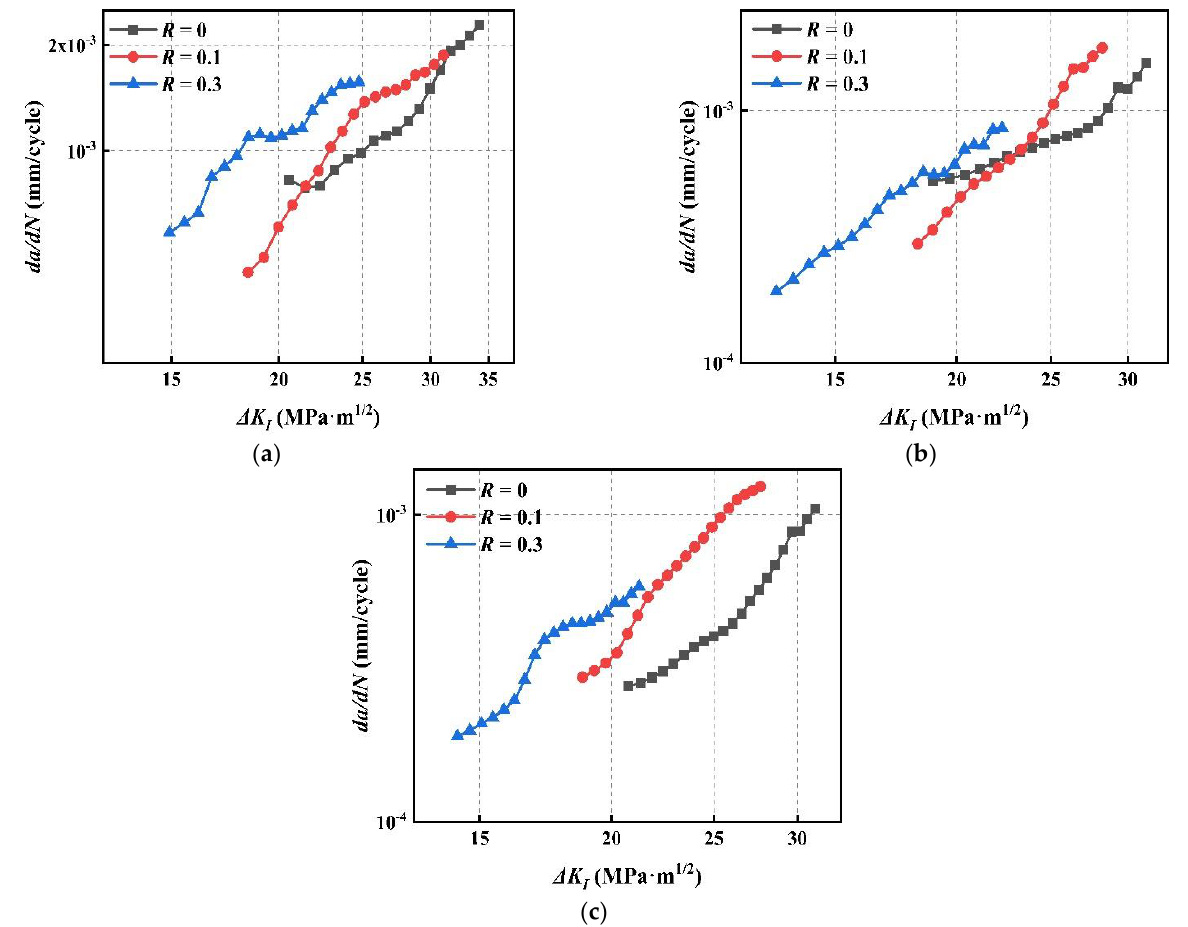
Figure 10. Where β = 45 ◦ , the relationship between FCGR and ∆ K I under different biaxial load ratios ( a ) λ = 0 ( b ) λ = 0.5 ( c ) λ =